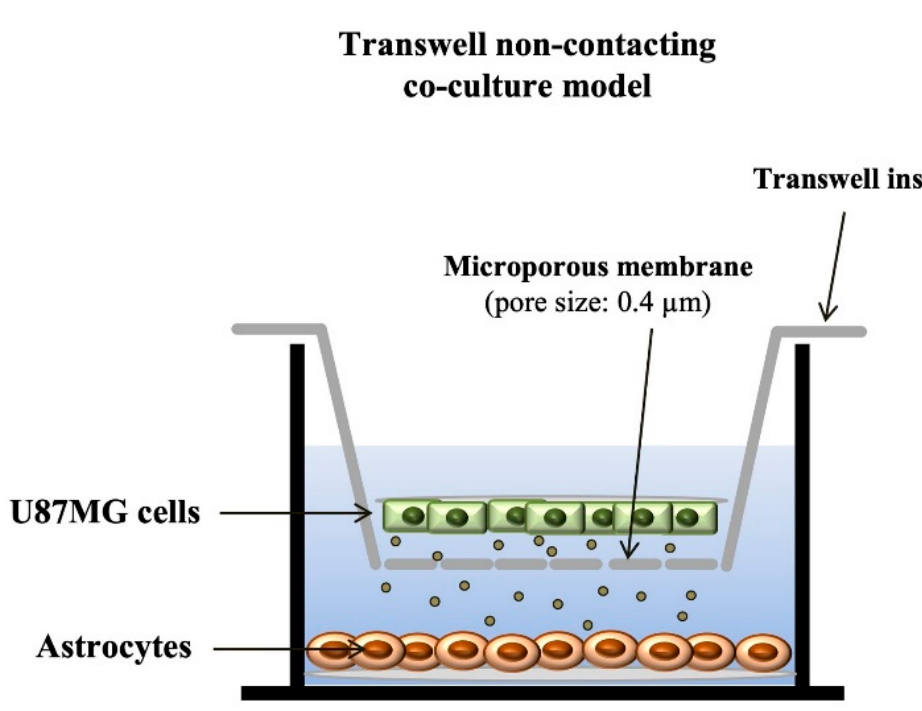
Figure 1. Illustration showing the trans-well co-culture system. The cartoon shows a non-contacting co-culture model of astrocytes and GBM cells. In detail, astrocytes and GBM cells are co-cultured in two different compartments, which are separated by a trans-well insert gifted of a microporous membrane. This, in turn, allows an indirect trans-cellular interaction through the diffusion of soluble factors. The culture in the lower compartment receives the treatment 24 h before the culture in the upper compartment is added. In this way the upper compartment is not directly receiving the treatment and it is mostly affected by the culture present in the lower compartment. Only cells from the upper compartment of each co-culture were counted.